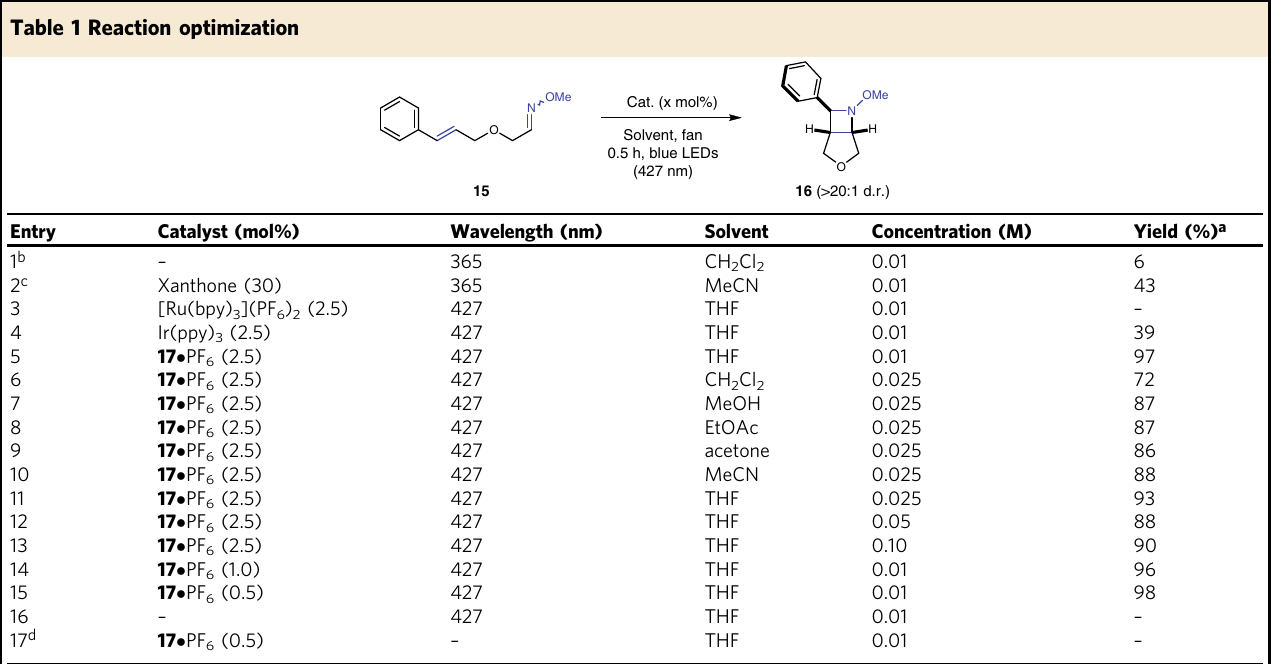
Conditions: Reactions performed on 0.1mmol scale under irradiation with a blue LED light (427nm) for 0.5h at ambient temperature (fan cooling) a Yield determined by quantitative 1 H NMR analysis from the crude mixture using an internal standard b For 24h c For 12h d Run in the